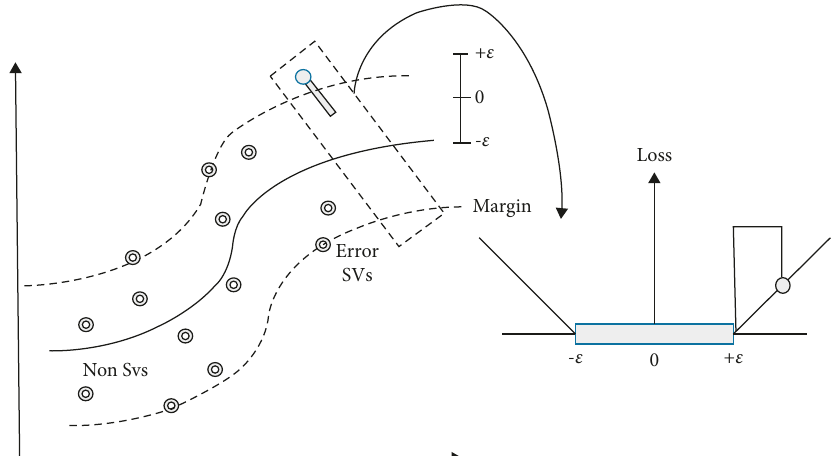
Figure 3: Illustrative diagram of the SVM